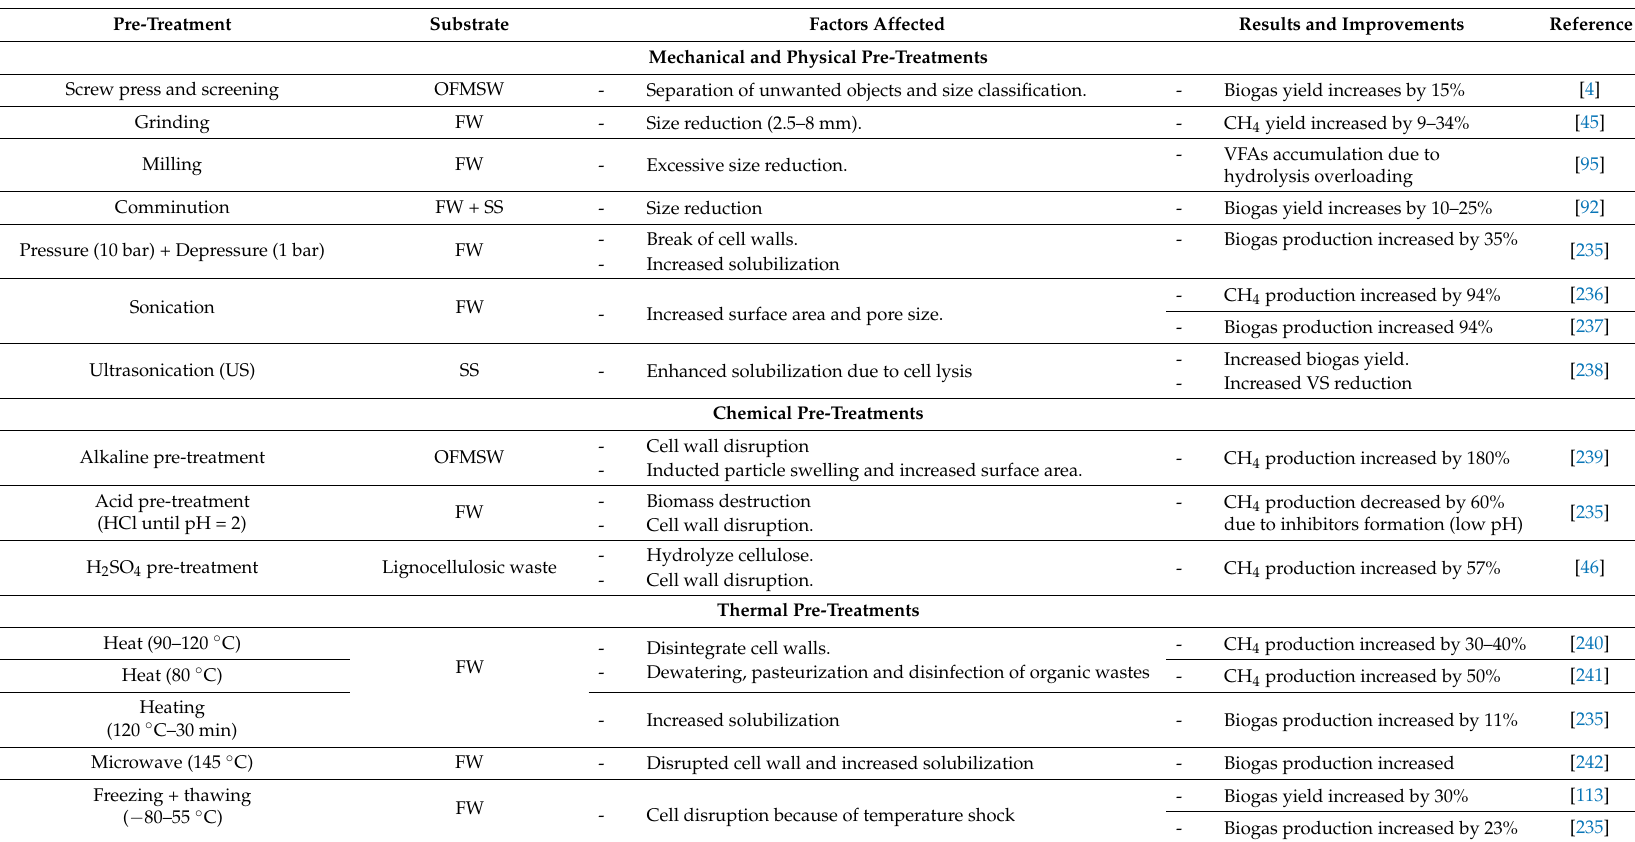
Table 4. Pre-treatments for anaerobic digestion and co-digestion of food waste: Basis and